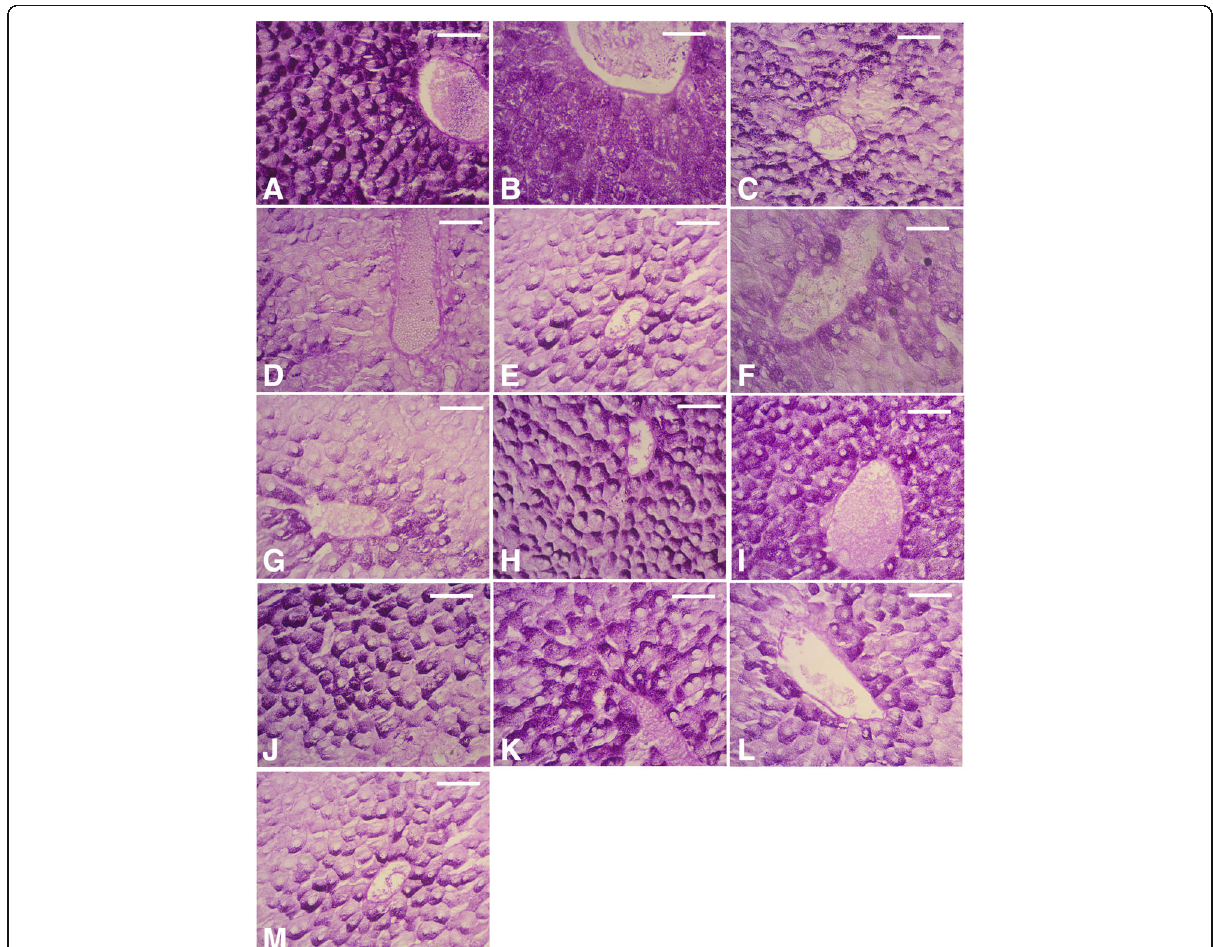
Fig. 2 Photomicrographs of PAS-stained liver sections of the control group ( a ). Acrylamide-administrated groups along the experimental periods ( b – d ) showing a decrease of carbohydrate contents. The chips feeding groups at 30, 45, and 60 days ( e – g ) showing a decrease in the carbohydrate contents as compared with the control group. Bee venom-treated ( h ) and BPF-treated ( i ) groups at 60 days of treatment showing similarity to the control. Acrylamide-administrated groups treated with either BV ( j ) or BPF ( k ) showing improvement of carbohydrate contents. Chips feeding groups treated with either BV ( l ) or BPF ( m ) showing improvement in the carbohydrate contents. PAS staining scale bar 10 μ